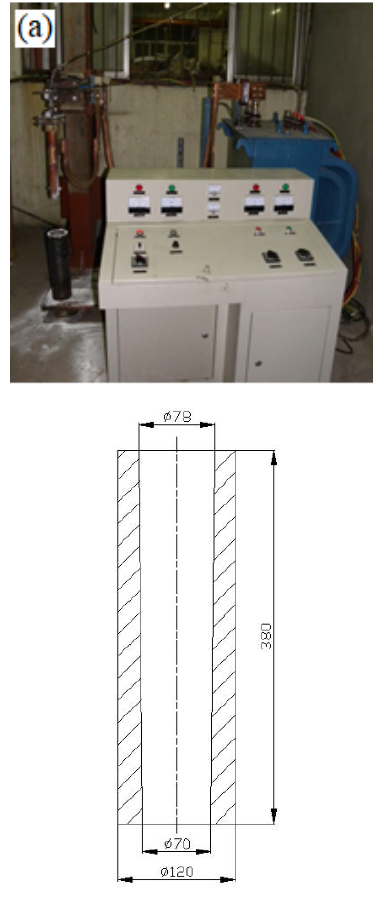
Figure 3: The apparatus of experiment (a) and the size of crystallizer (b).